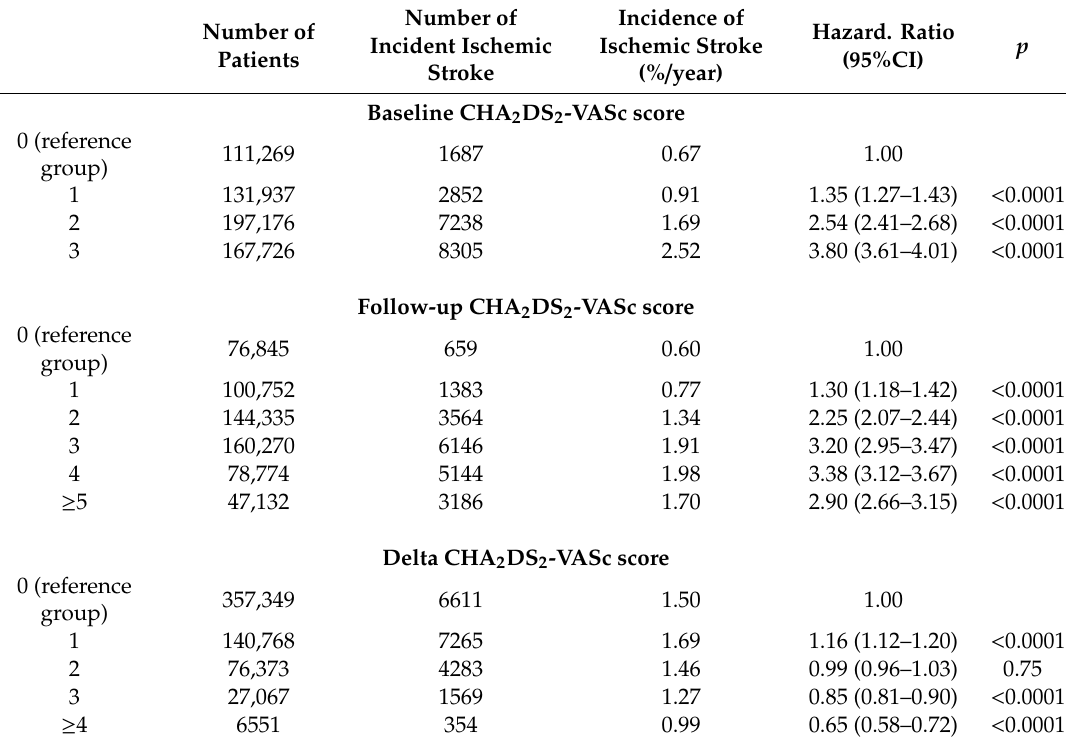
Table 3. Risk of ischemic stroke in AF patients with di ff erent baseline follow-up and